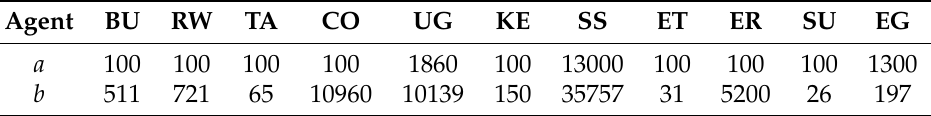
Table 3. The parameters defining each agent’s economic objective